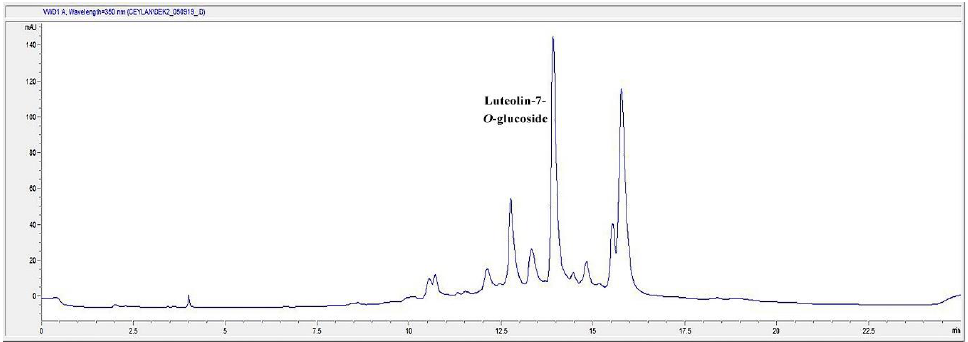
Figure 8. The HPLC Chromatogram of the decoction (D) extract of TS.